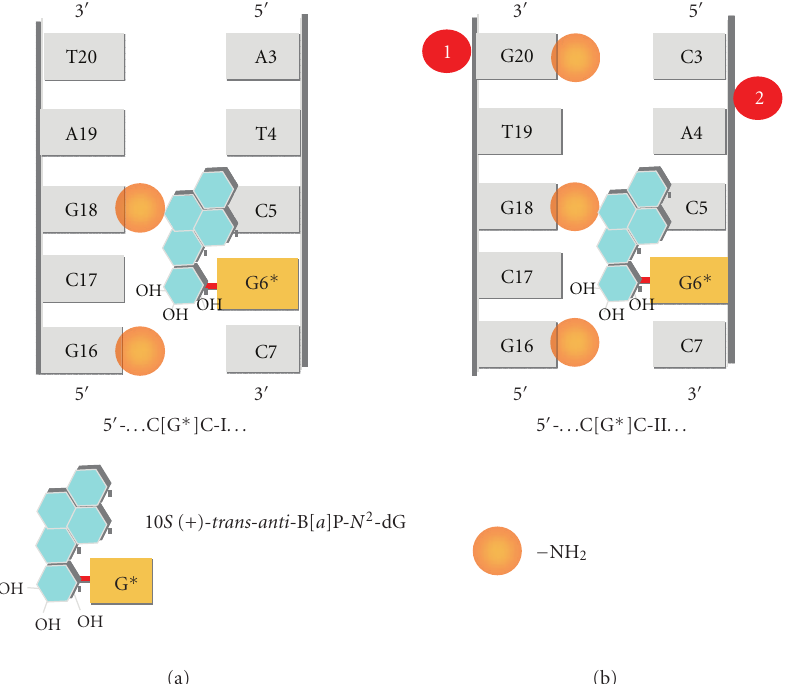
Figure 5: Cartoon representation of the lesion-containing duplexes (a) 5 (cid:3) - ... C[G ∗ ]C-I ... and (b) 5 (cid:3) - ... C[G ∗ ]C-II ... . Note that 5 (cid:3) - ... C[G ∗ ]C-I ... and 5 (cid:3) - ... C[G ∗ ]C-II ... di ff er beginning with the next nearest neighbor to [G ∗ ] and beyond. The locations of the key guanine amino group “1” and highly flexible dinucleotide C-A step “2”, present only in the 5 (cid:3) - ... C[G ∗ ]C-II ... sequence, are marked in red balloons.